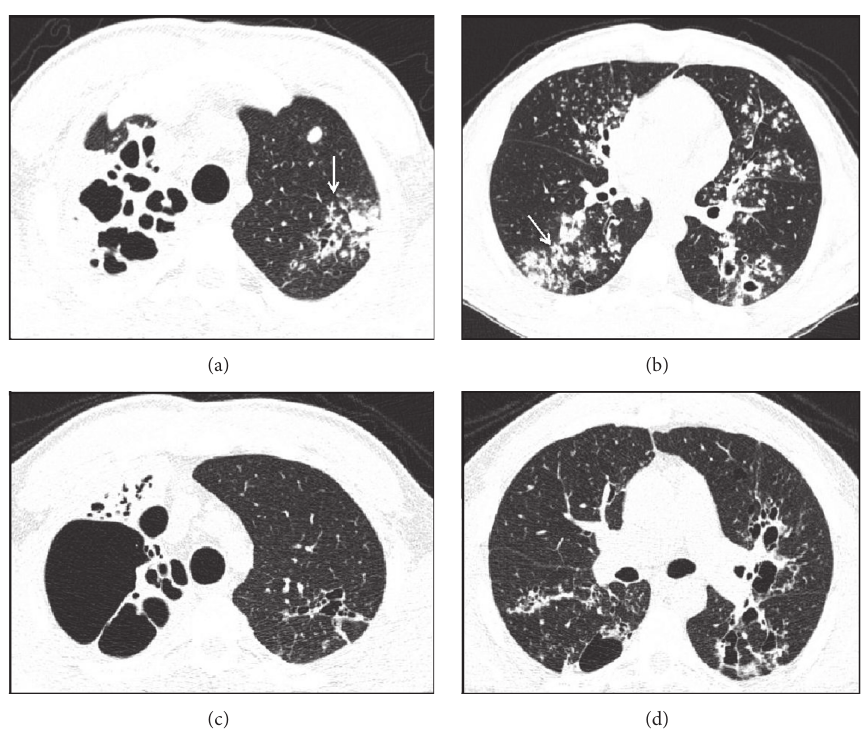
Figure 1: Computed tomography findings in TB. Axial views ((a) and (b)) before treatment indicating the presence of extensive areas of parenchymal damage characterized by cavitary lesions and bronchiectasis on the right in addition to larger grouped nodules and airway nodules configuring the tree-in-bud pattern, with some resembling a clover on the left (arrows). (c) and (d) represent sections obtained after treatment indicating the presence of gross residual changes characterized by bubbles and bronchiectasis intermingled with areas of fibrosis.